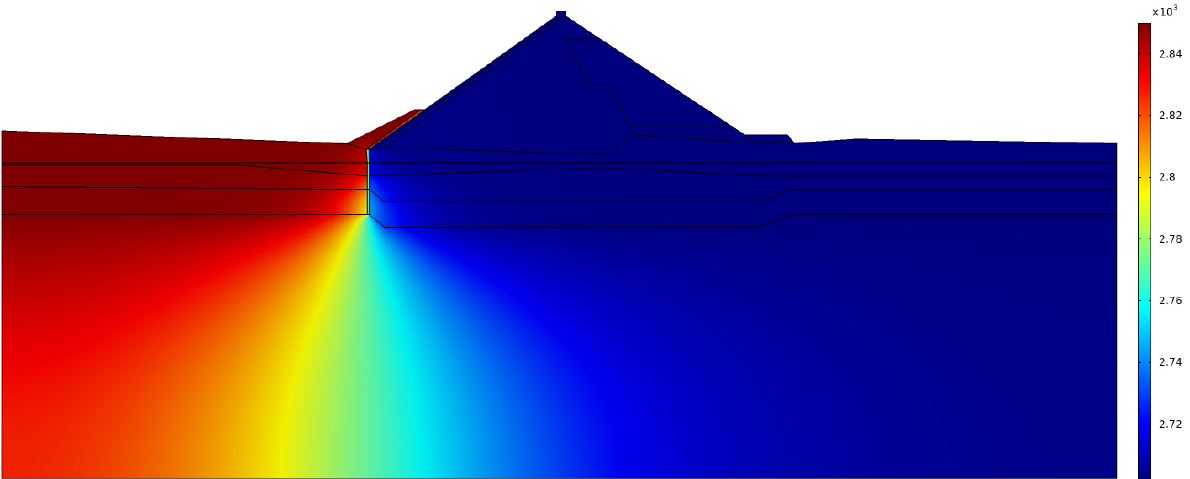
Figure 8. Distribution of seepage contours at the maximum section of the